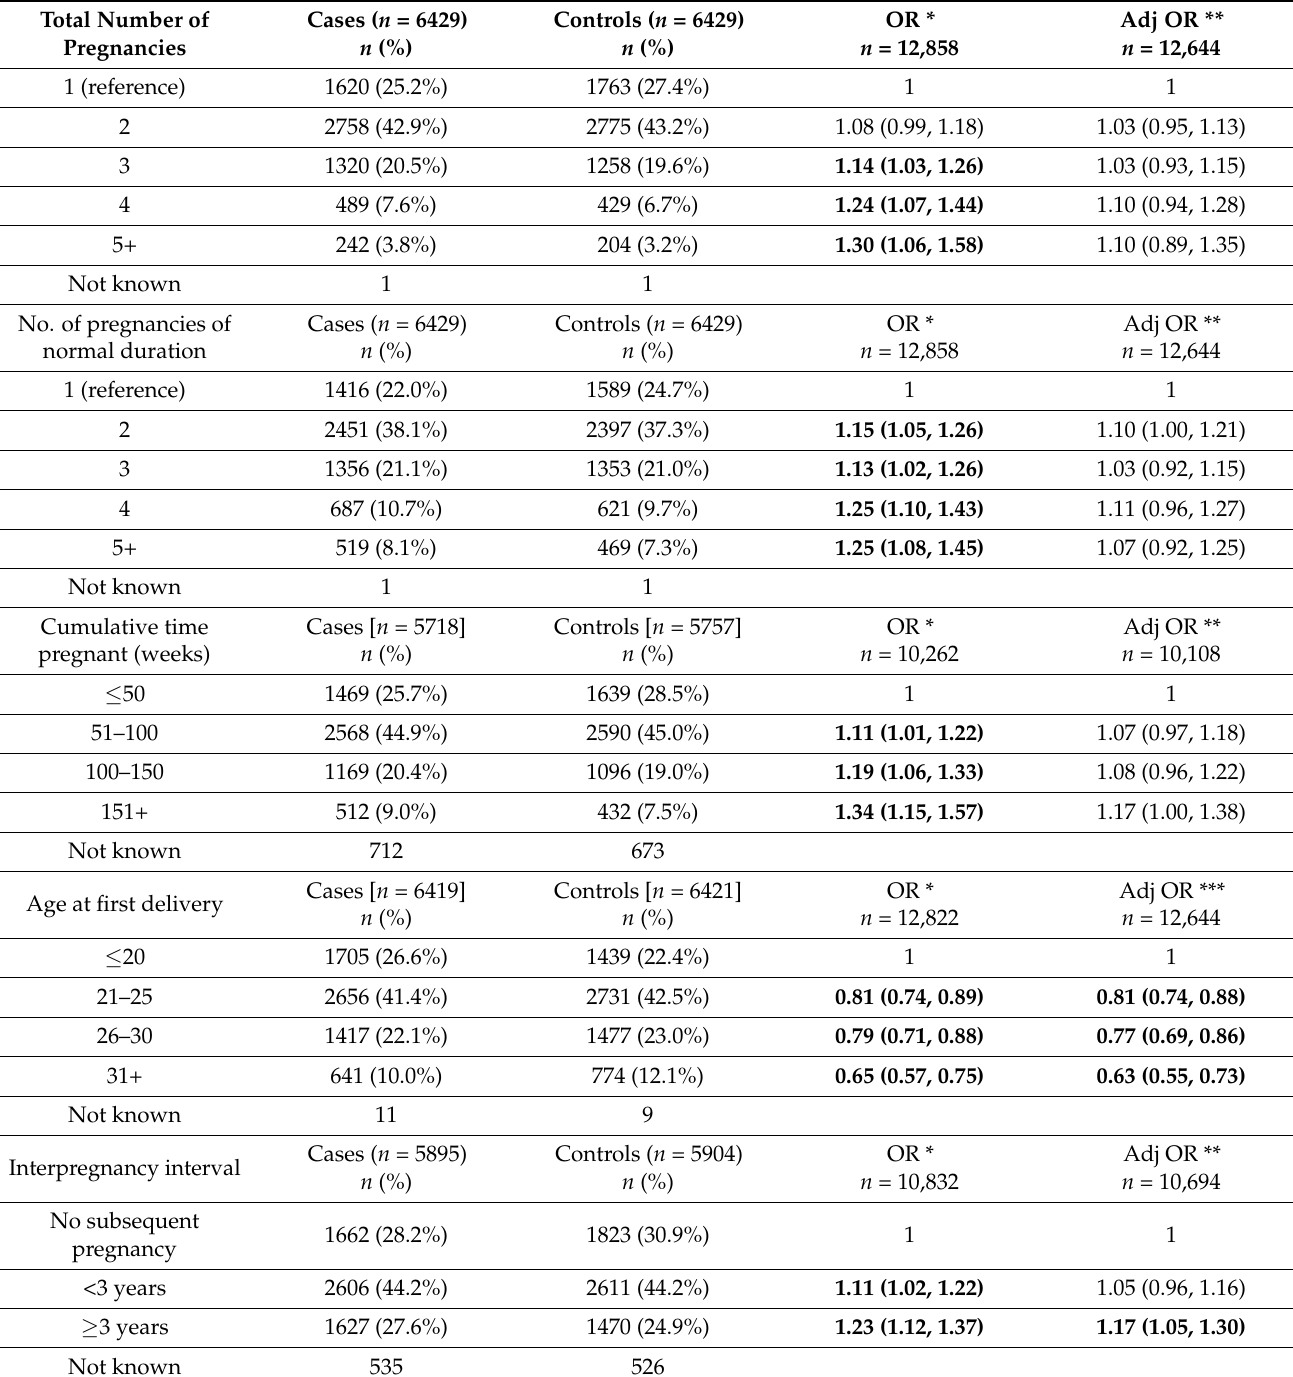
Table 2. Comparison of reproductive variables between women with (cases) and without (controls) cancer.